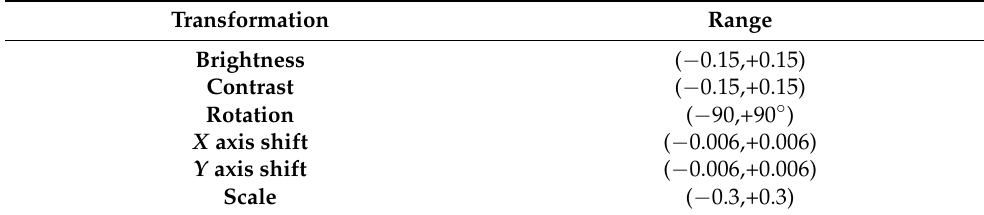
Table 2. Transformation ranges of data augmentation.